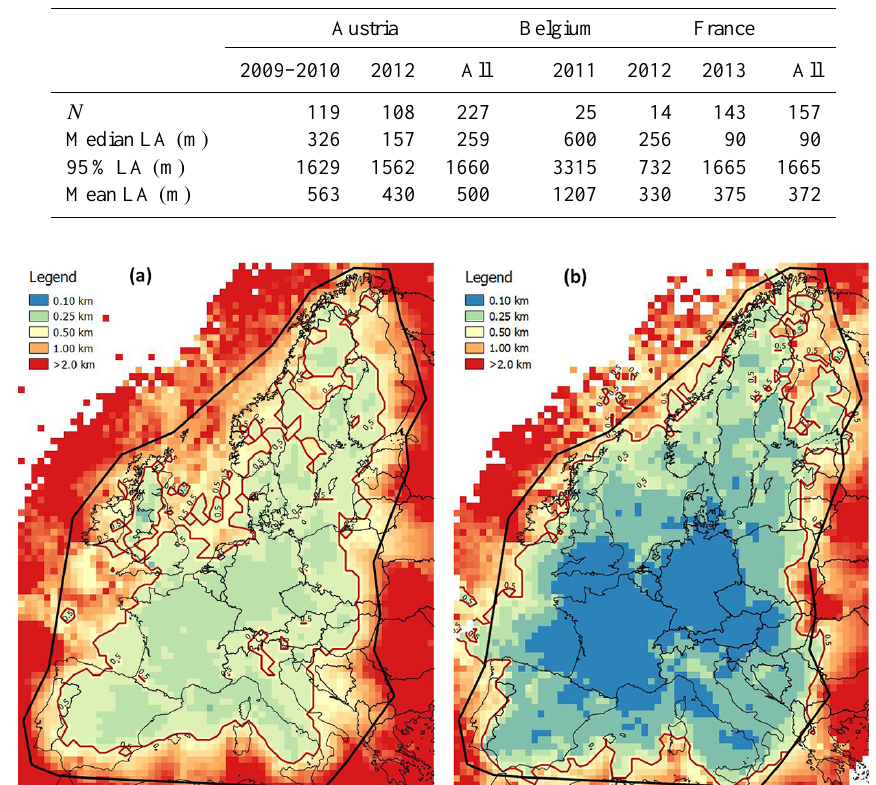
Figure 5. Median semi major axis for the whole EUCLID network for (a) period 2005–2014 and (b) for 2014 only. The black polygon shows the region for the data analysis in Poelman et al. (2016). The red line represents the 0.5km contour line of median semi major